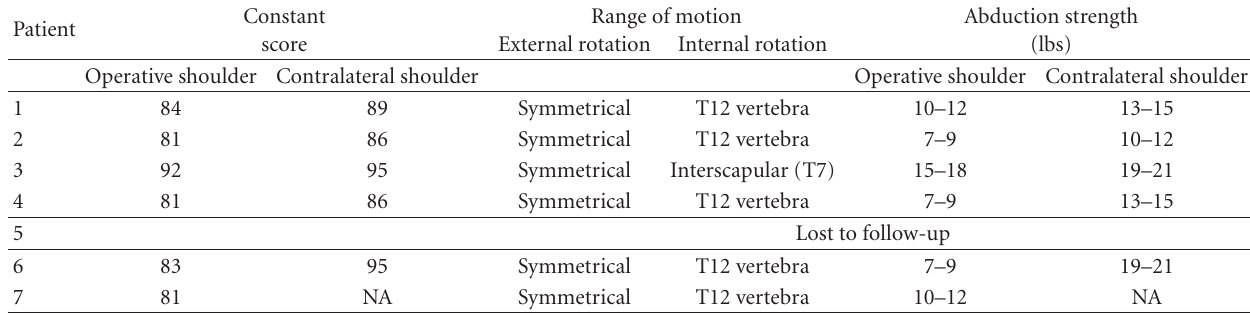
Table 2: Functional